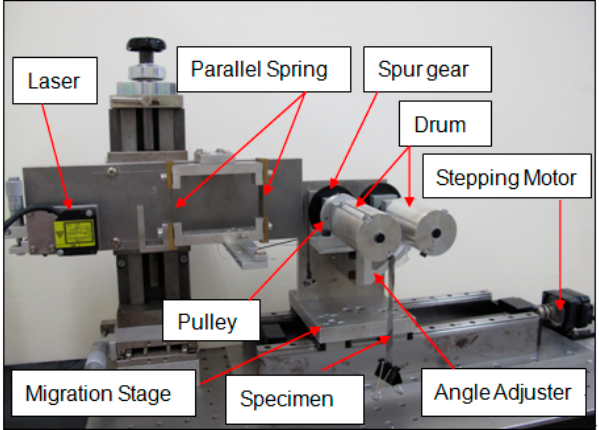
Figure 1. T-peel test apparatus set-up (1 cm photo:5 cm actual).